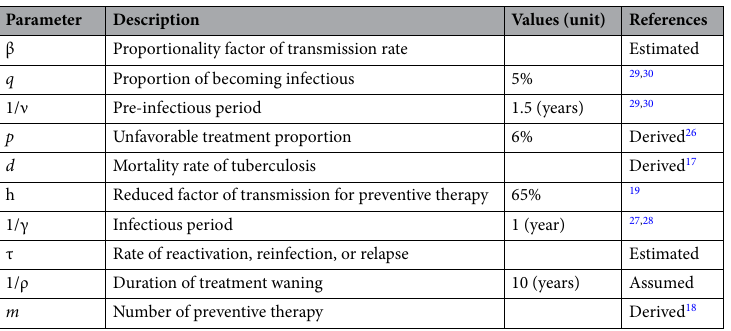
Table 1. Parameters of TB transmissions model.